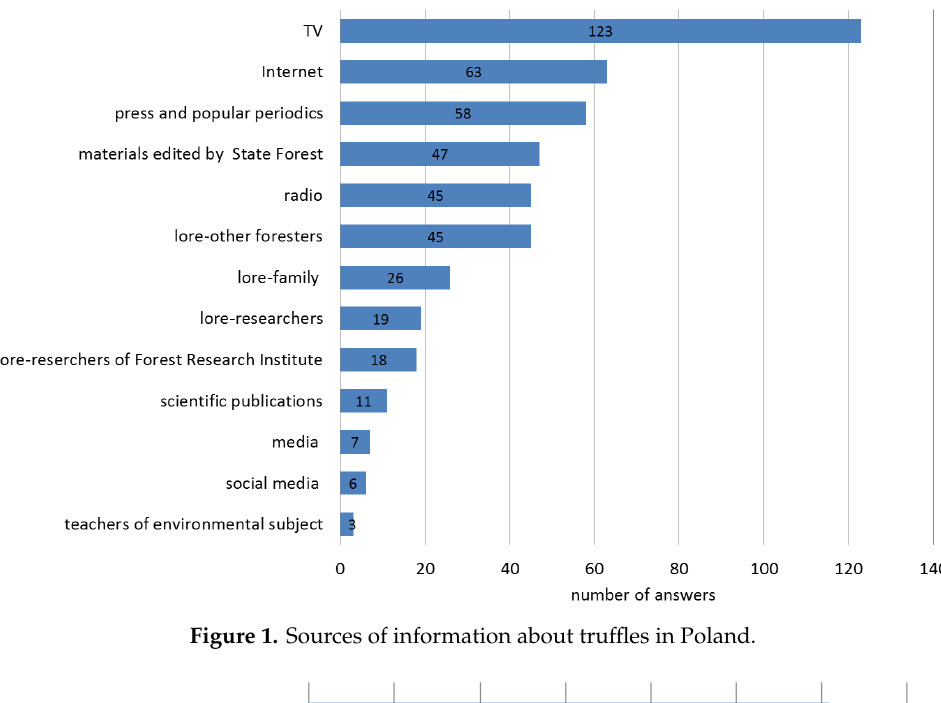
Figure 1. Sources of information about truffles in Poland.